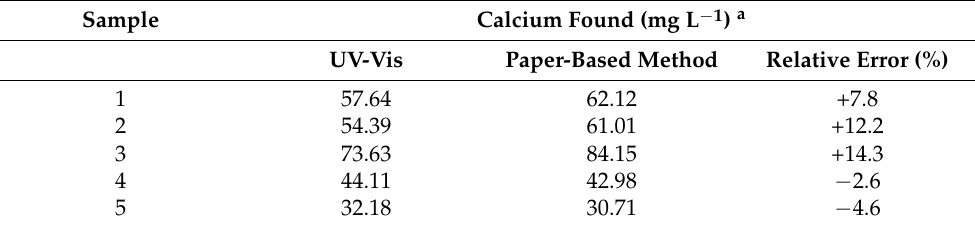
Comparison of the results obtained with the paper-based method and with the UV–Vis